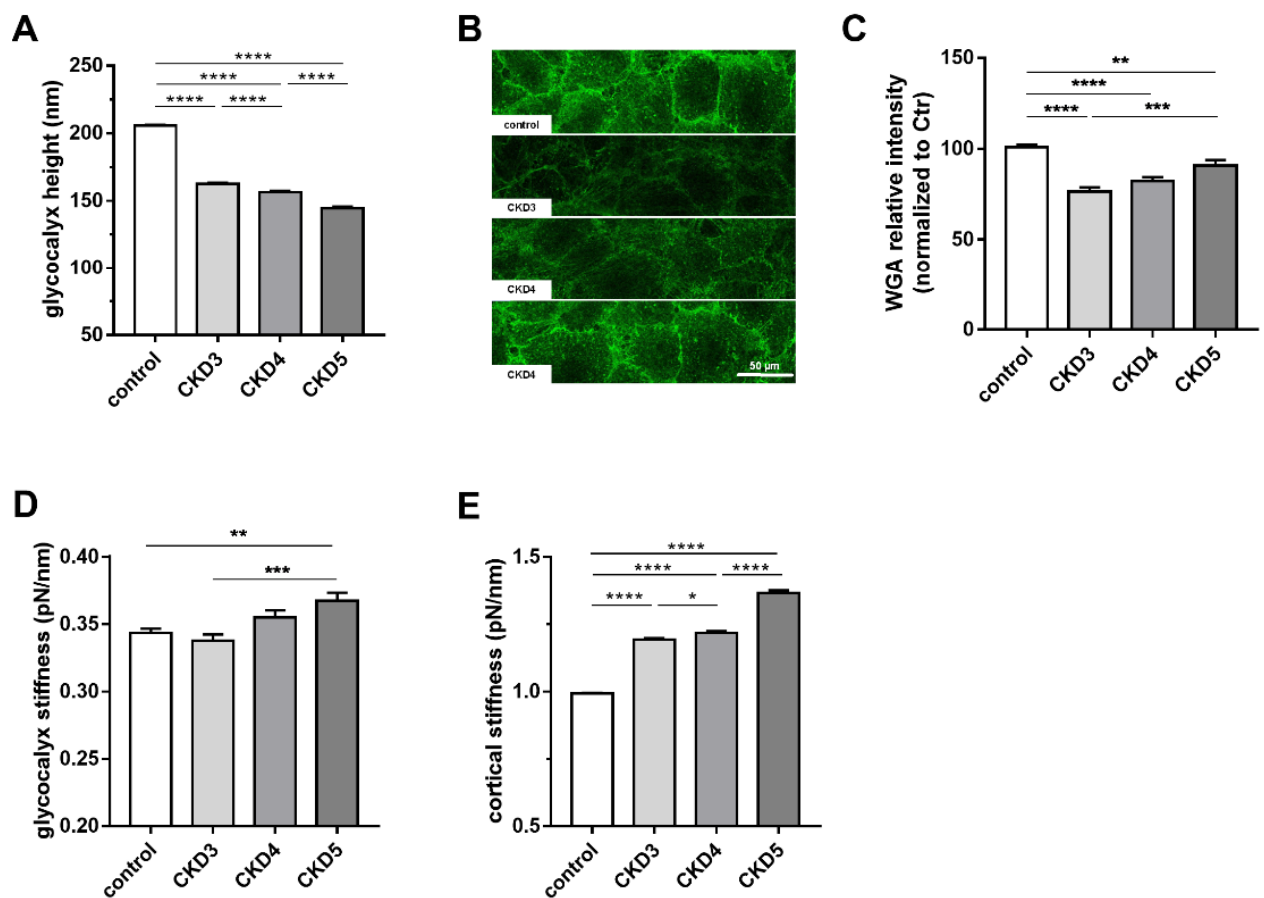
Figure 1. Incremental effect of diminished kidney function on the structure and mechanics of endothelial cells. HUVECs were treated with 10% serum from pediatric patients with CKD 3–5 for 24 h. ( A ) eGC height was measured using AFM based nano-intendation measurements. The eGC height was gradually decreased with each stage of CKD (N ≥ 7). ( B ) The decrease in eGC was confirmed by staining with FITC-labeled WGA. ( C ) Treatment with CKD 3–5 sera decreases the WGA fluorescence intensity at all CKD stages compared to controls (N = 7–25; n = 76–170). ( D ) eGC stiffness increases with higher CKD stages (N ≥ 7). ( E ) Stiffness of the actin cortex was measured by nano-intendation measurements. Cortical stiffness increases gradually with each CKD stage (N = 7–24, n = 182–612). Significance levels in all plots are indicated by * p < 0.05, ** p < 0.01, *** p < 0.001, **** p < 0.0001.